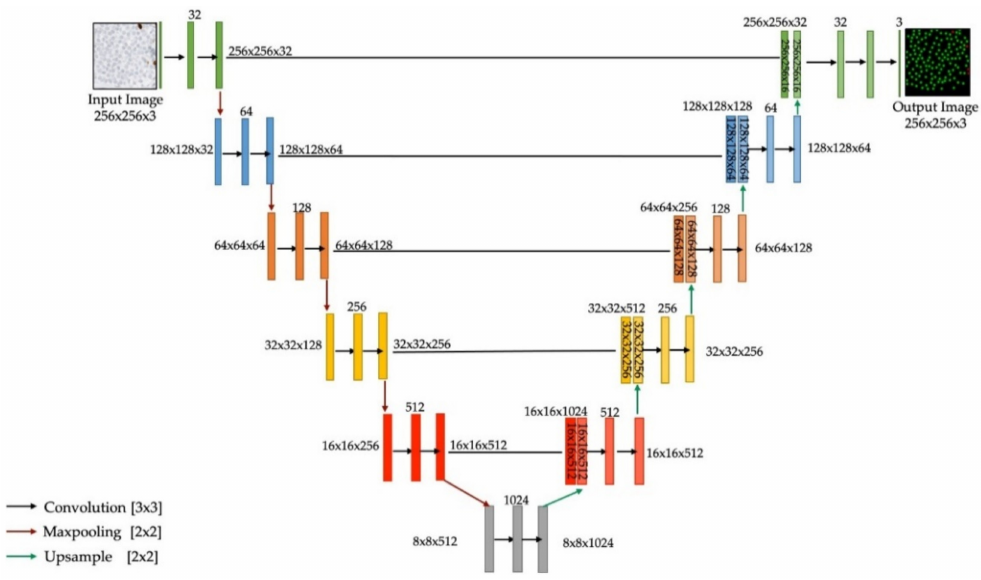
Figure 5. Ki67+/ − detection is preformed through a U-NET